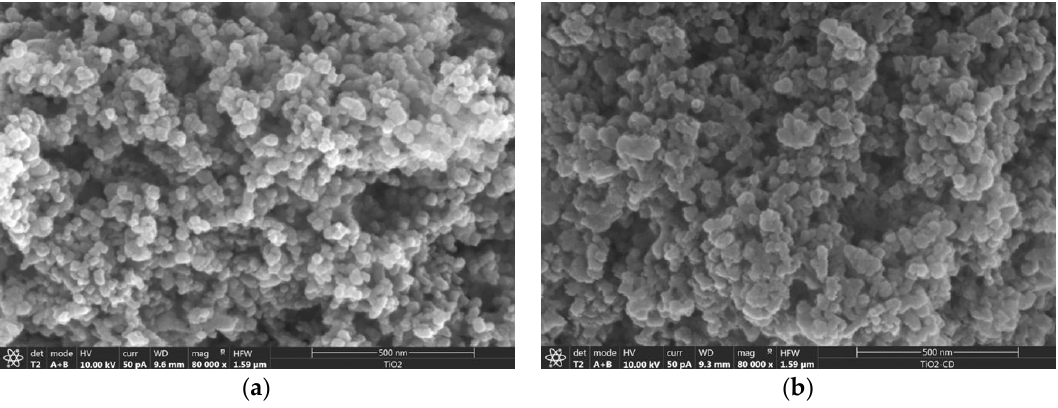
Figure 2. Scanning electron microscopy (SEM) micrographs corresponding to ( a ) as-received TiO 2 NPs and ( b ) β CDTiO 2 NPs.